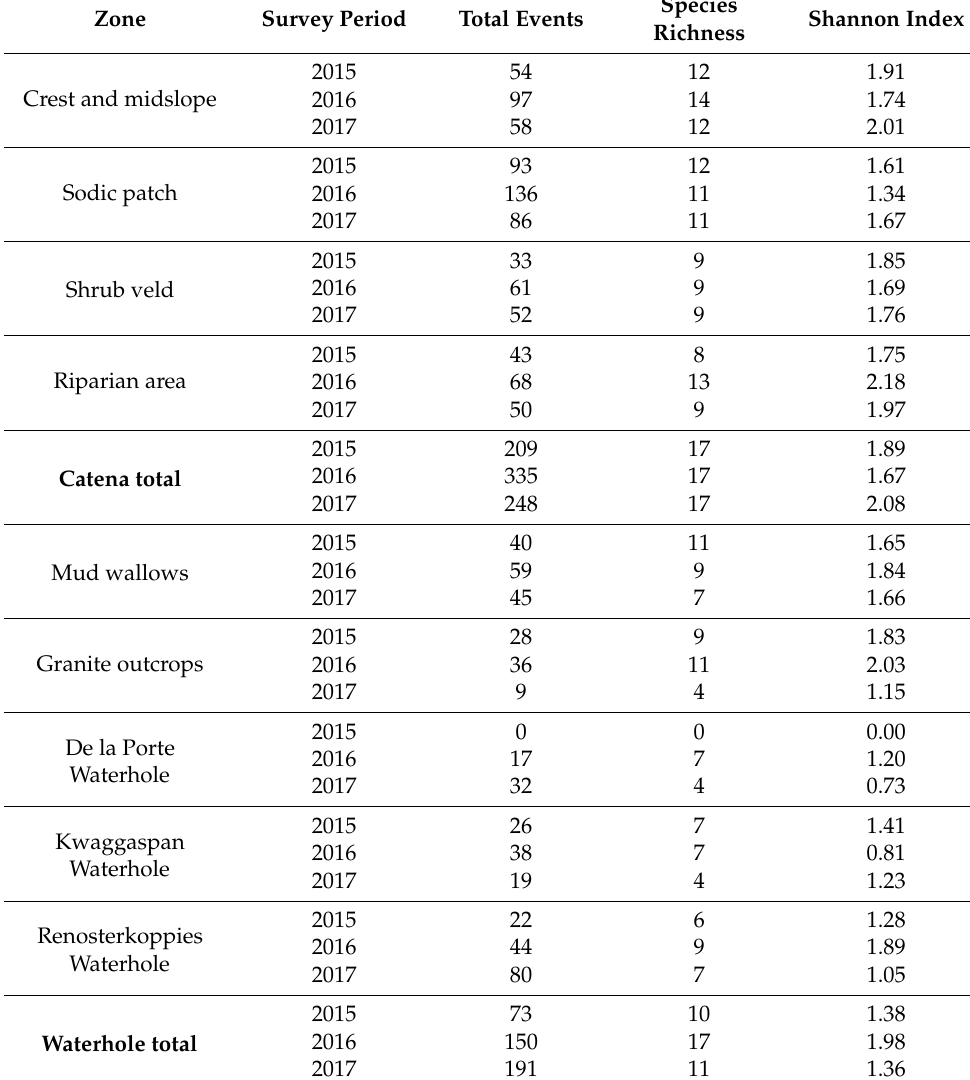
Table 3. Summary of the sum total of events (observations), species richness (number of species) and the Shannon–Weiner Diversity Index values per survey period for each zone. Total values of the catena and the waterholes (including their surrounding areas) are also